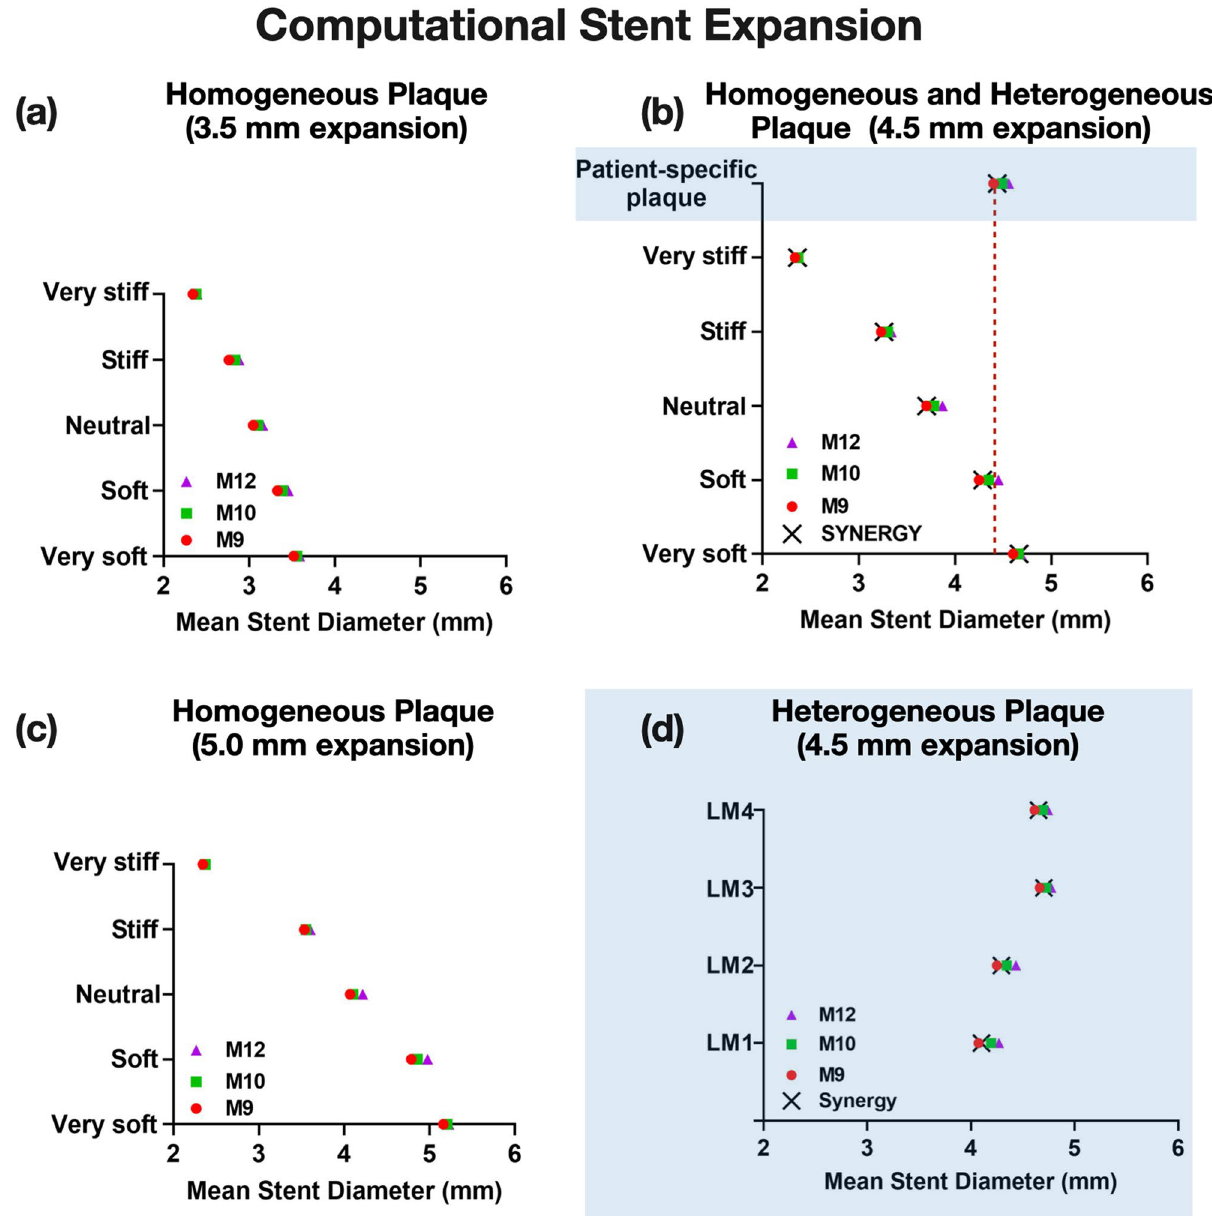
( c ) 5.0 mm stents in homogeneous plaque environment. ( d ) The same pattern was seen when the stent designs were expanded within heterogeneous patient-specific plaques (shaded areas of graph) for all n = 4 left main